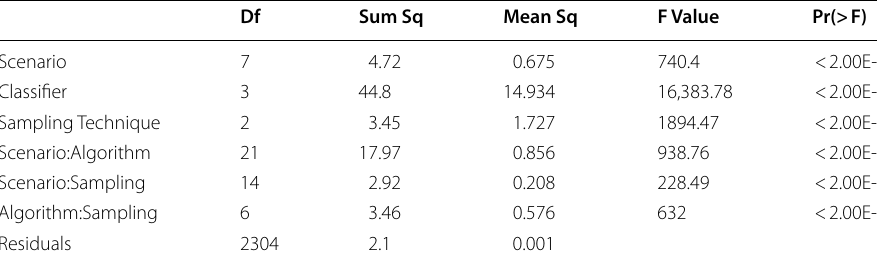
Table 10 Three-factor ANOVA for F1 score